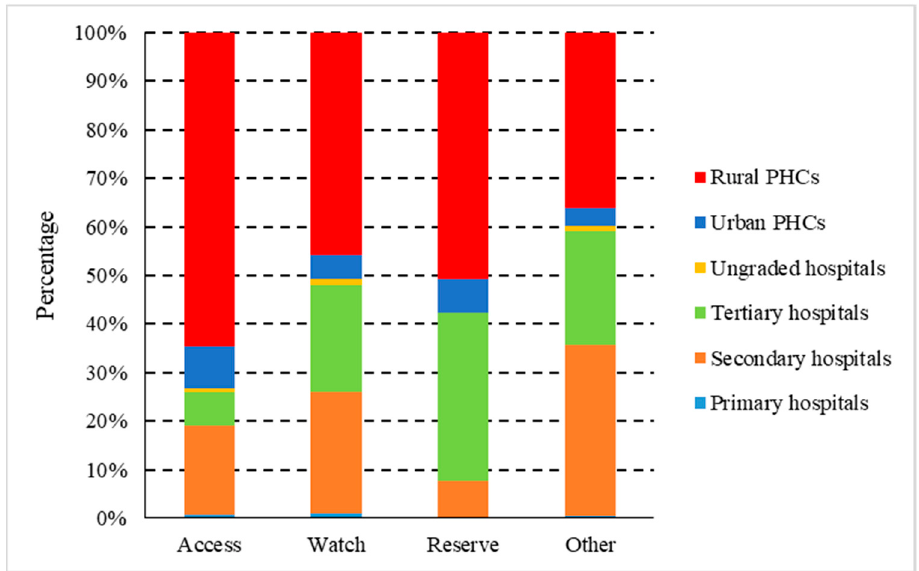
Figure 6. Proportional consumption (%) of antibiotics used in healthcare institutions by AWaRe categorization in Shaanxi Province, western China, 2015–2018. (AWaRe, the “Access, Watch and Reserve” classification.)